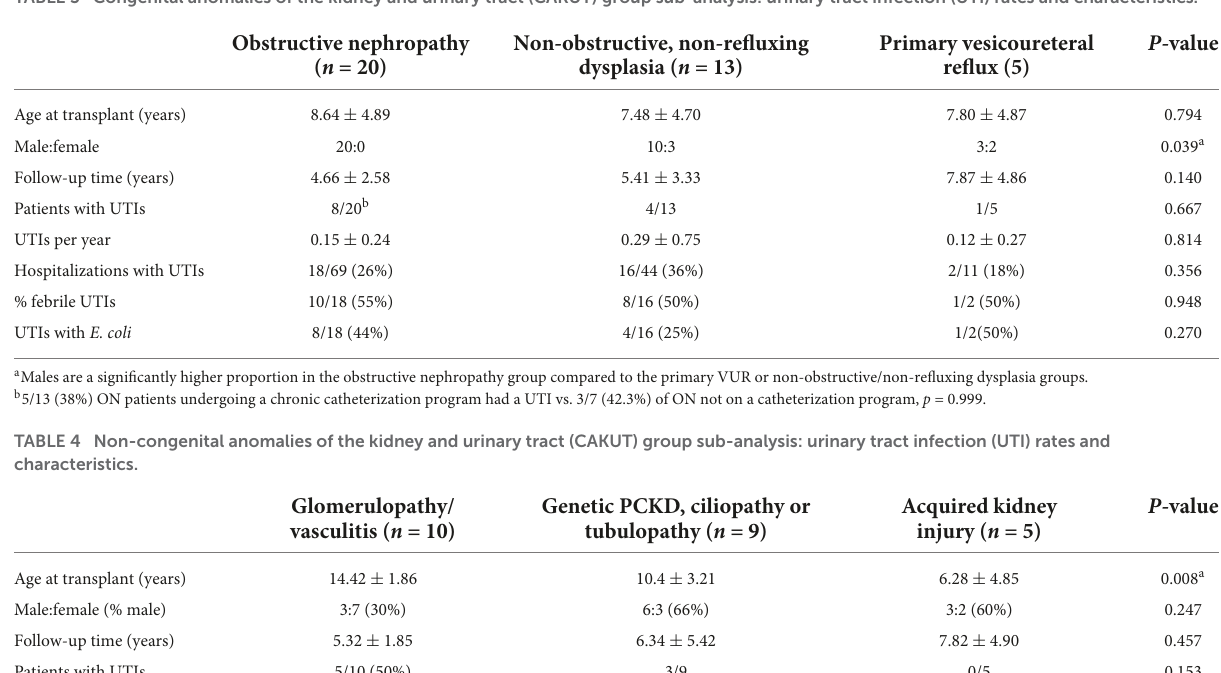
Non-obstructive, non-refluxing dysplasia ( n = 13)